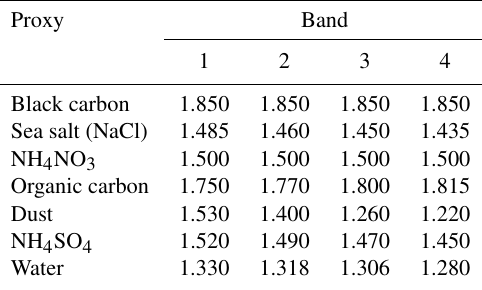
Table A2. Real parts of the refractive indices of the proxies listed in Table A1 at the centres of the geoCARB spectral bands.